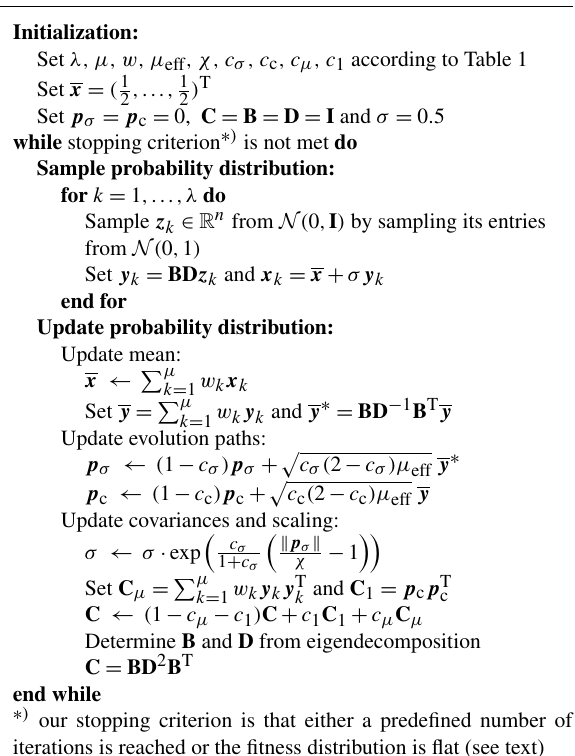
Algorithm 1 The (µ/µ w ,λ)